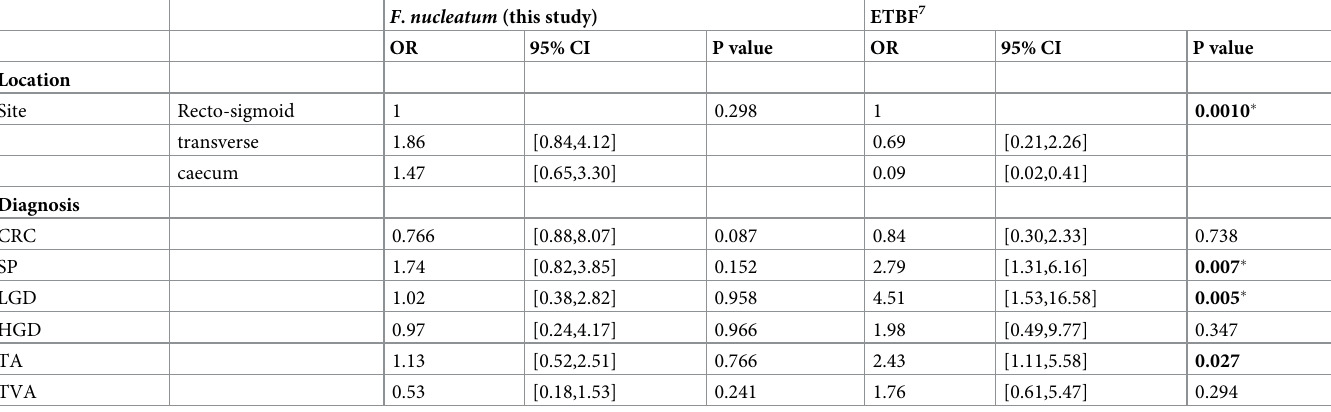
Table 3. Association of F . nucleatum and ETBF positivity with clinical lesions in the colonic biopsy cohort, adjusted for age and gender. F . nucleatum (this study) ETBF 7 OR 95%